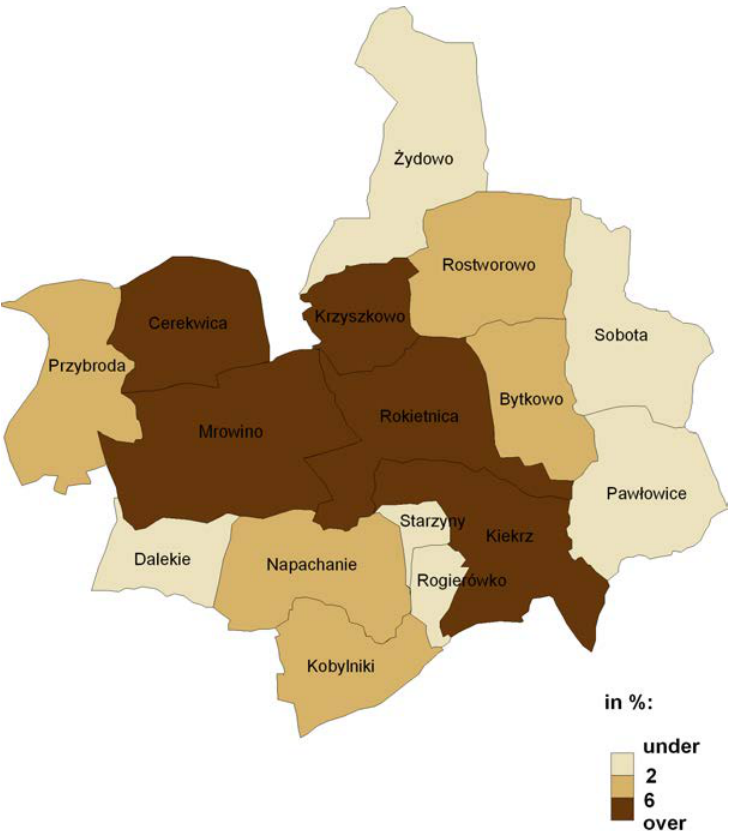
Fig. 3. Housing areas, 2014 (Rokietnica commune in the system of geodetic districts). Source: own compilation on the basis of data from the Poviat Centre of Geodetic and Cartographic Documentation in Poznań.